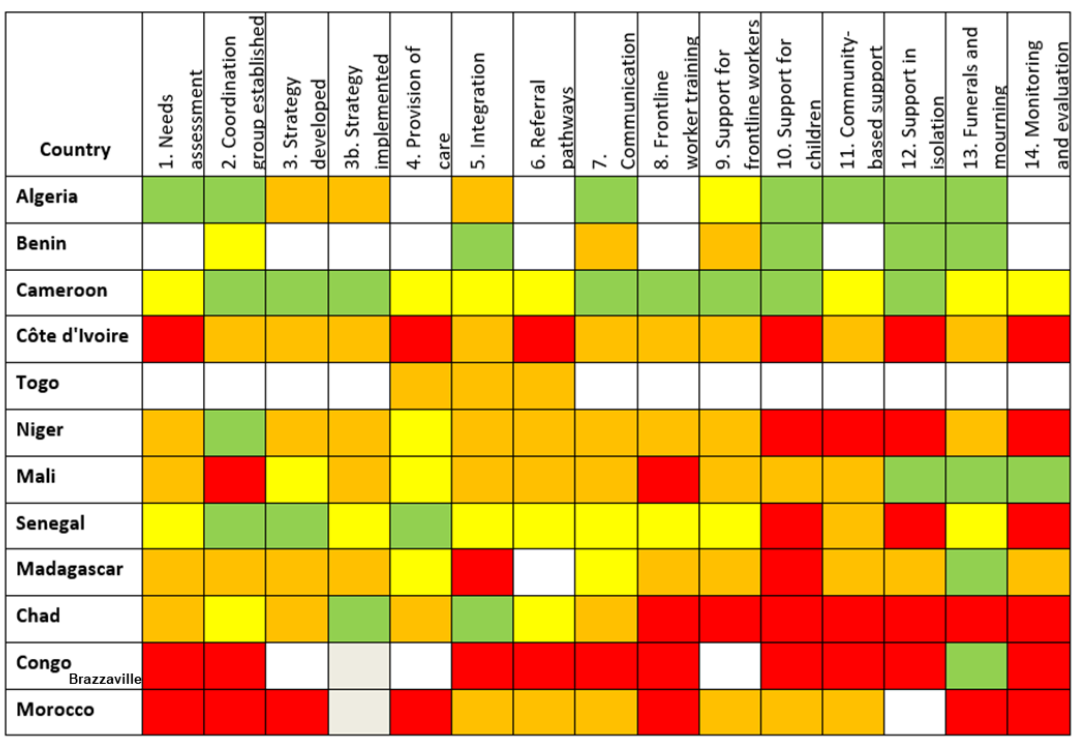
Figure 2. Francophone countries’ responses to survey based on IASC 14 recommended MHPSS activities in the COVID-19 outbreak.